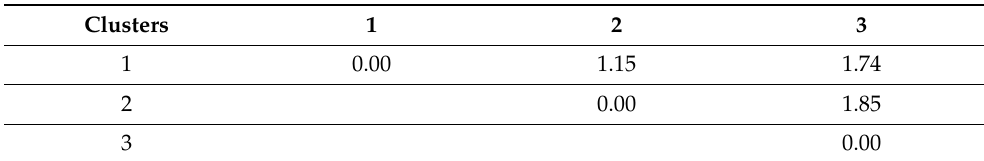
Table 9. Euclidean distance between clusters obtained by the k-means method for dehydrogenases, phosphatase and urease. Clusters